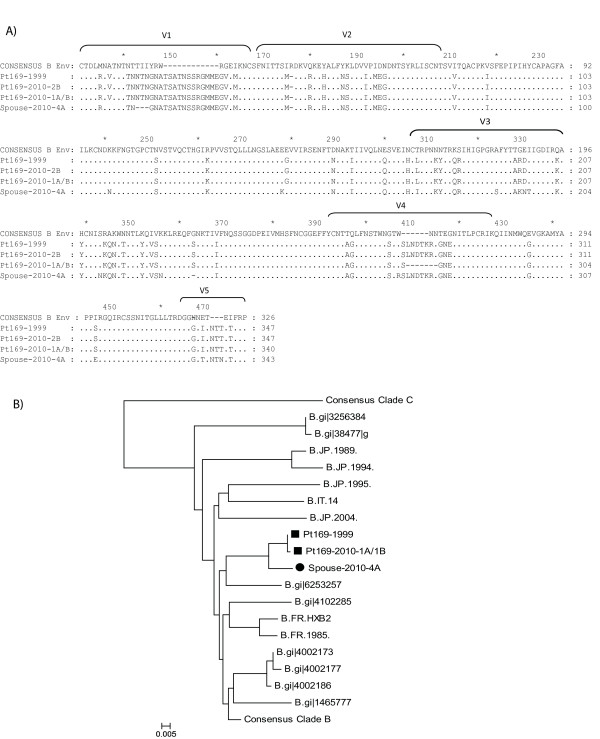
Phylogenetic Analysis: An alignment of the variable regions of env is shown for replication-competent isolates obtained from Patient 169 and his spouse. Numbering is from the first amino acid in gp120. (A). The sequences are also compared to other Clade B sequences(B). Phylogenies were estimated by using a classical approach, functioning under a maximum-likelihood (ML) optimality criterion.